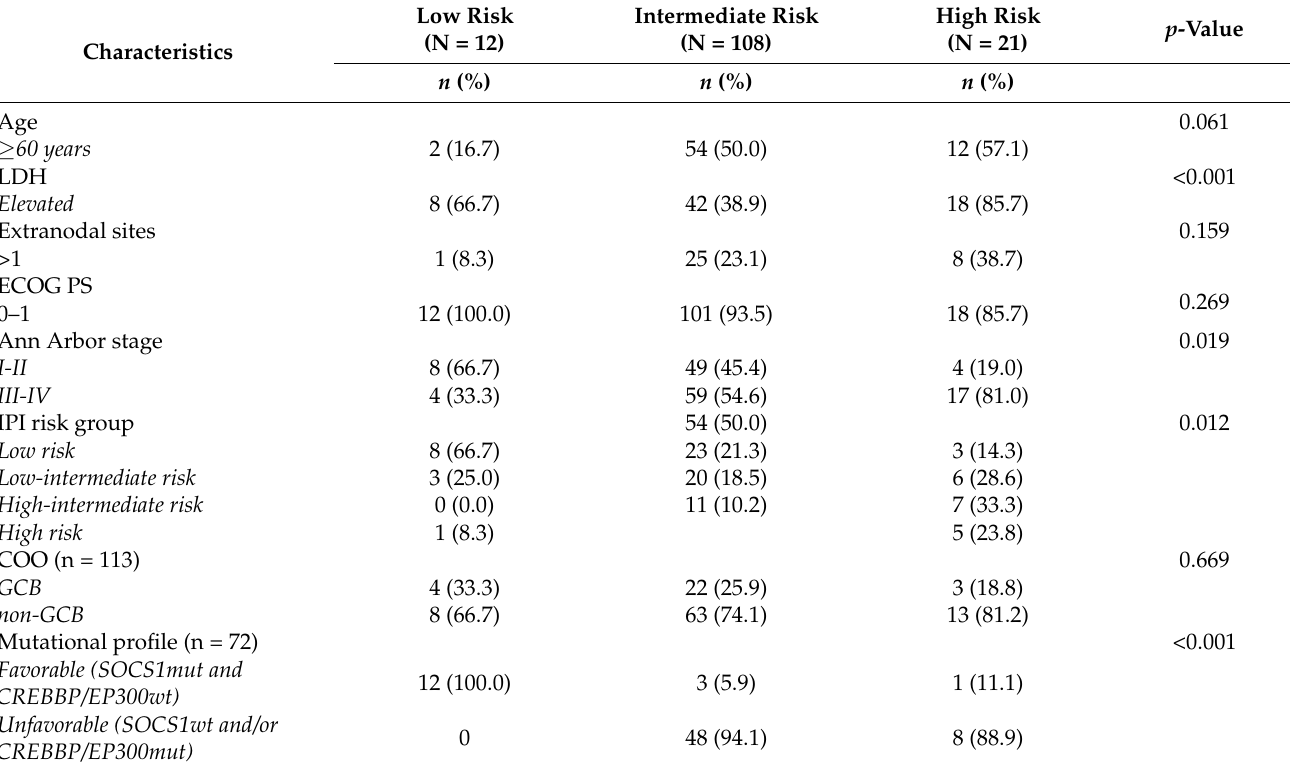
Table 3. Patient features according to the prognostic group defined by the classification tree for